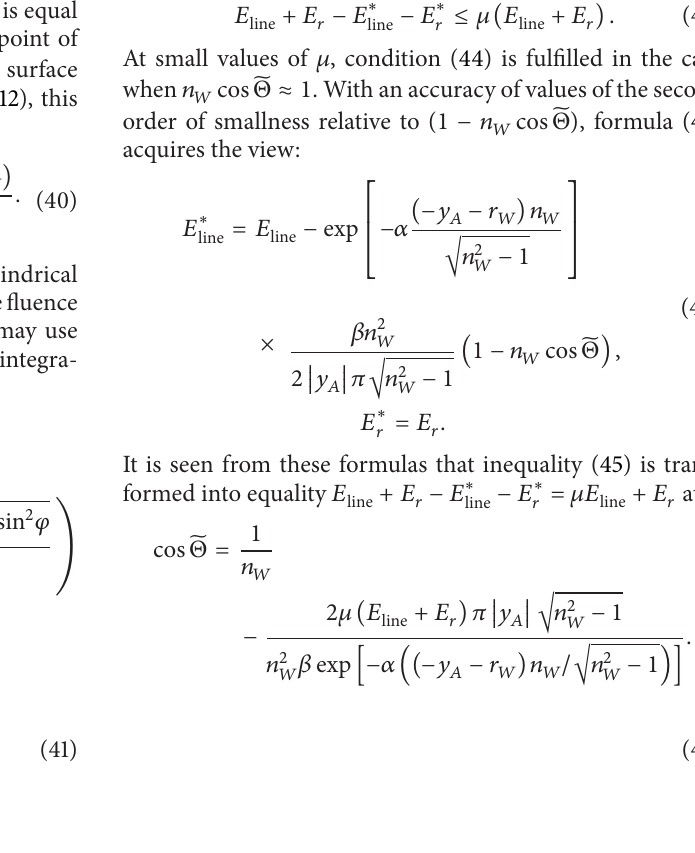
of paths of these rays in air lie on surface S . The surface S 󸀠 is symmetric with respect to surface S relative to plane 𝑥𝑦 (Figure